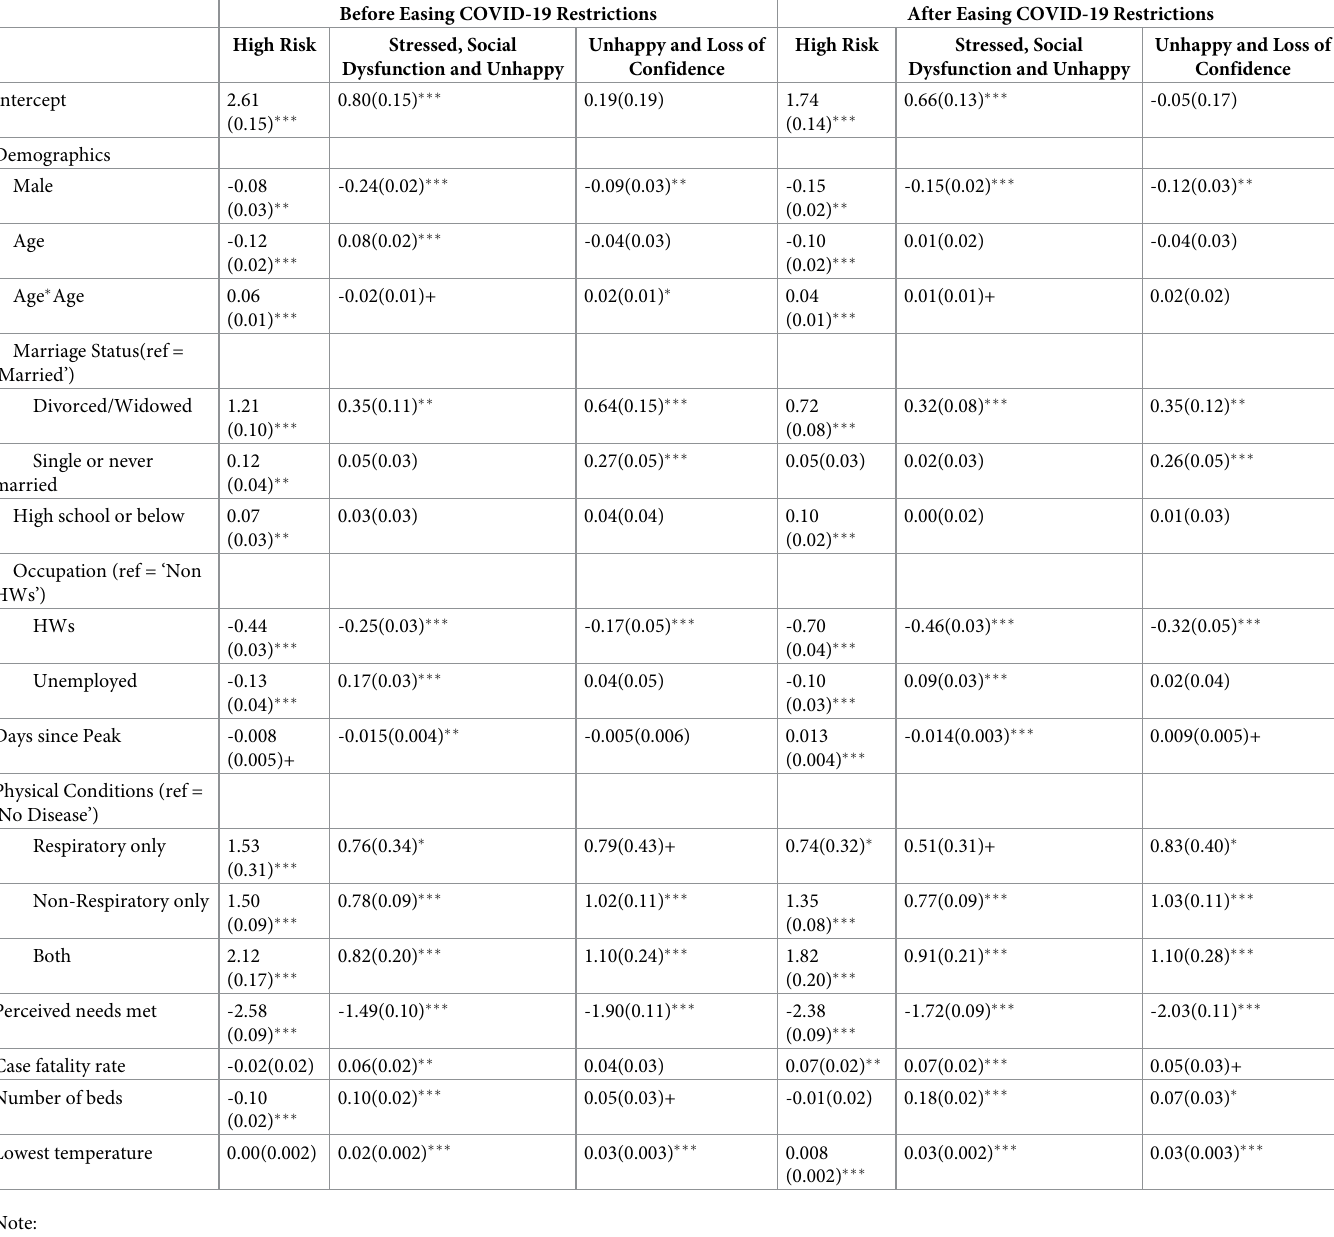
Table 3. Parameter estimates (standard errors) from fitted multinomial logistic regression predicting mental health